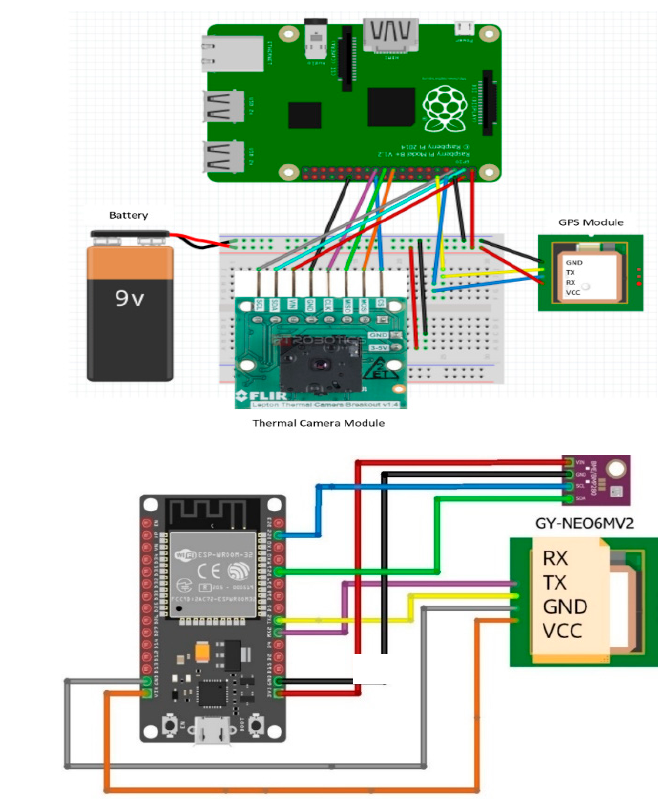
Table 2. The configurations of the experiment’s components.